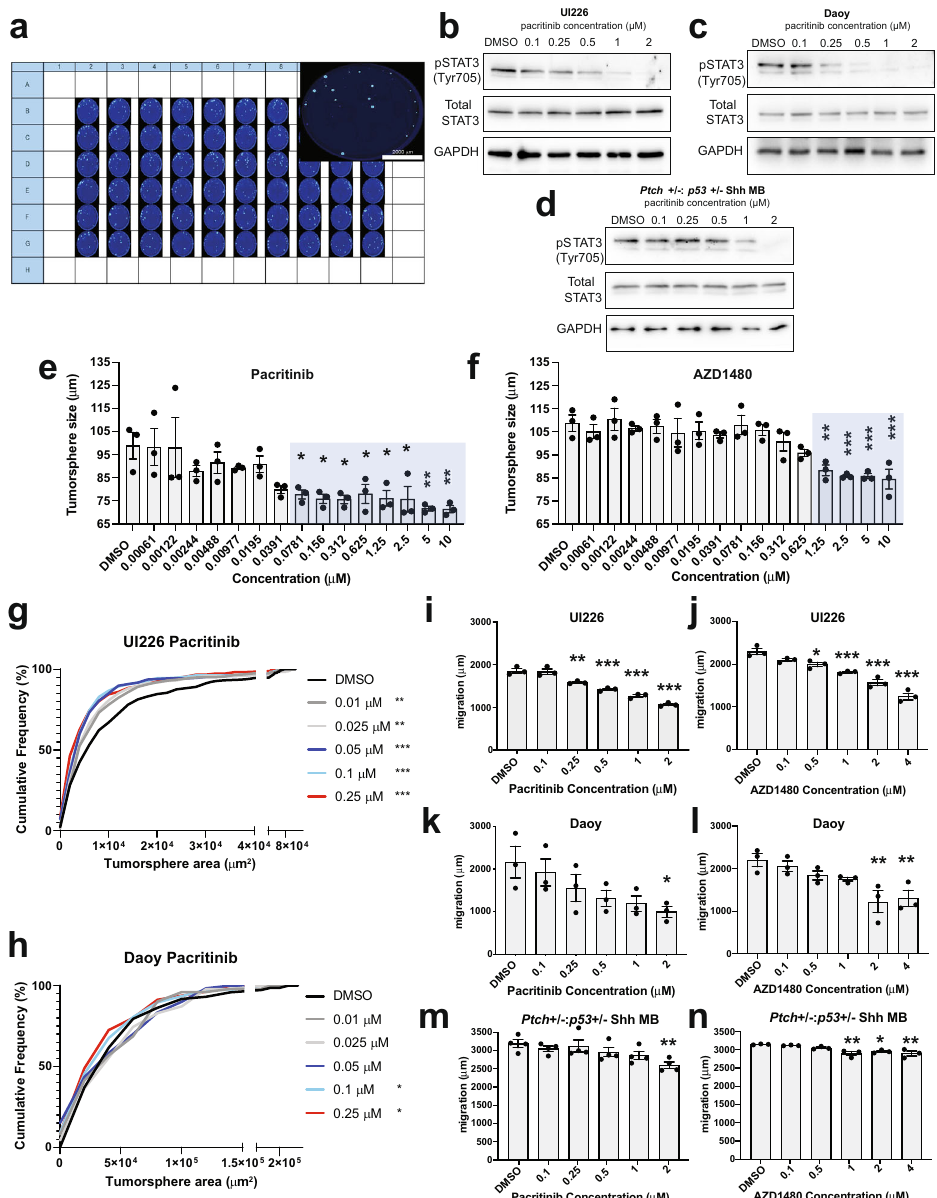
Fig. 3 JAK/STAT3 inhibitors decrease tumorsphere size and cell migration in vitro. a High-content tumorsphere drug screening set-up and 96-well plate depicting Hoechst 33342 stained tumorspheres following treatment with various drug concentrations. Approximately 4000 UI226 cells were seeded into each well of a 96-well ultra-low attachment plate. Cells were seeded in various drug concentrations or in the presence of vehicle (DMSO at 0.0025%) at 37 °C for 5 days. Following incubation, tumorspheres were fi xed and stained with a 4% formaldehyde + 300 ng/mL Hoechst 33342 solution at 4 °C O/N. Western blot for pSTAT3 (Tyr705) activation, total STAT3 and GAPDH following treatment of UI226 ( b ) Daoy ( c ) or Ptch + / − : p53 + / − ( d ) MB tumorspheres with pacritinib for 3 h. UI226 tumorsphere size following treatment with increasing doses of pacritinib ( e ) and AZD1480 ( f ). Error bars: SEM. N = 3 biological replicates and n = 3 technical replicates for each biological replicate. Results were analyzed using one-way ANOVA and a Dunnett ’ s test for multiple comparisons. p < 0.05*, p < 0.01**, p < 0.001***. For pacritinib treated cells in ( e ): 0.0781 μ M, p = 0.0432; 0.156 μ M, p = 0.0221; 0.312 μ M, p = 0.0200; 0.625 μ M, p = 0.0459; 1.25 μ M, p = 0.0244; 2.5 μ M, 0.0211; 5 μ M, p = 0.0046; 10 μ M, p = 0.0042. For AZD140 treated cells in ( f ): 1.25 μ M, p = 0.0016; 2.5 μ M, p = 0.0004; 5 μ M, p = 0.0004; 10 μ M, p = 0.0002. Cumulative frequency distribution of tumorsphere size for UI226 ( g ) and Daoy ( h ) following treatment with various concentrations of pacritinib. Tumorsphere size was analyzed using 2-sample Kolmogorov – Smirnov tests. p < 0.05*, p < 0.01**, p < 0.001***. For pacritinib treated UI226 tumorspheres in ( g ): 0.01 μ M, p = 0.0073; 0.025 μ M, p = 0.0017; 0.05 μ M, 0.1 μ M and 0.25 μ M, p < 0.0001. For pacritinib treated Daoy tumorspheres in ( h ): 0.1 μ M, p = 0.0277; 0.25 μ M, p = 0.0107. UI226 ( i , j ), Daoy ( k , l ) and Ptch + / − : p53 + / − MB ( m , n ) cells exhibit a decrease in cell migration following treatment with pacritinib ( i , k , m ) and AZD1480 ( j , l , n ). Error bars: SEM. N = 3 or 4 biological replicates. Results were analyzed using one-way ANOVA and a Dunnett ’ s test for multiple comparisons. For UI226/pacritinib treated cells ( i ): 0.25 μ M, p = 0.0041; 0.50, 1.0 and 2.0 μ M pacritinib, p < 0.0001. For UI226/AZD1480 treated cells ( j ): 0.5 μ M, p = 0.0139; 1.0 μ M, p = 0.0004; 2.0 and 4.0 μ M, p < 0.0001. For Daoy/pacritinib treated cells ( k ): 2 μ M, p = 0.0362. For Daoy/AZD1480 treated cells ( l ): 2.0 μ M, p = 0.0041; 4.0 μ M, p = 0.0078. For Mouse SHH MB/pacritinib treated cells ( m ): 2.0 μ M, p = 0.0084. For Mouse SHH MB/AZD1480 treated cells ( n ): 1.0 μ M, p = 0.0028; 2.0 μ M, p = 0.0167; 4.0 μ M, p = 0.0029. COMMUNICATIONS BIOLOGY| (2022) 5:697